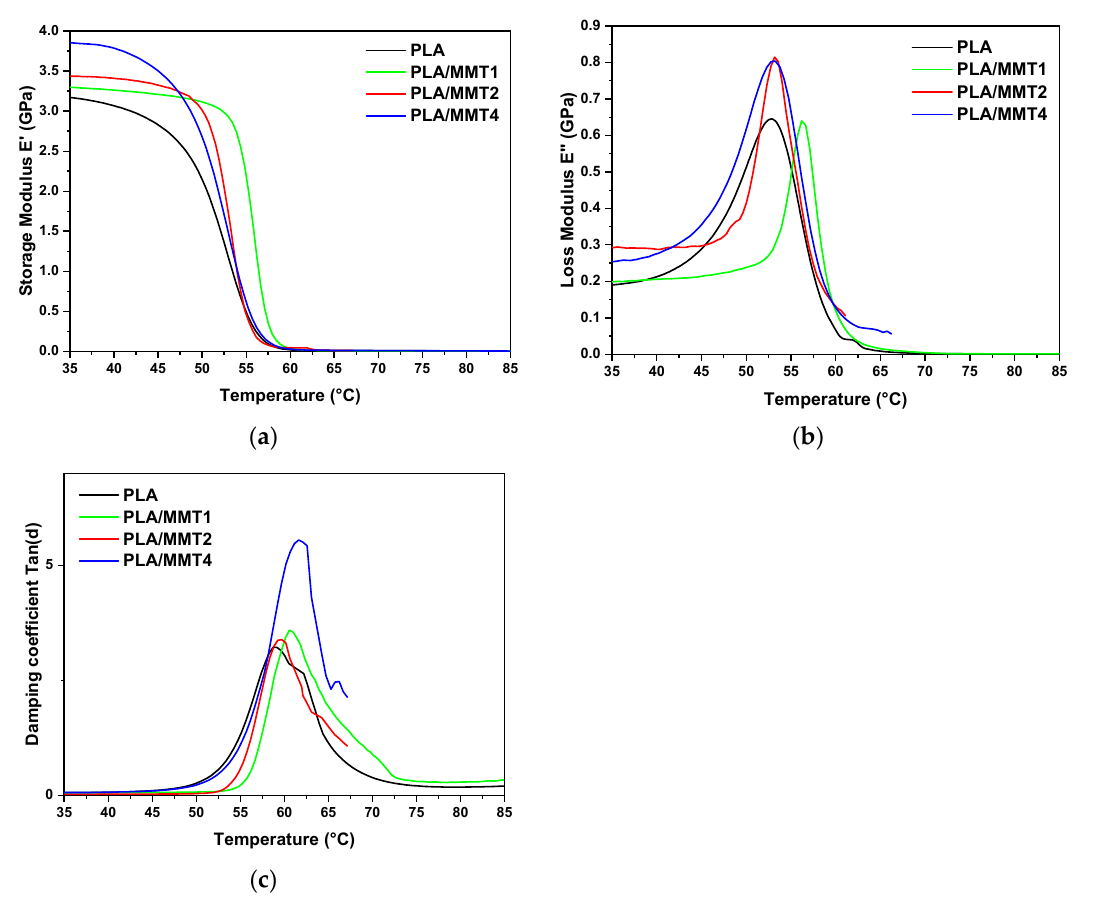
Figure 10. Effect of MMT content on the ( a ) E i Compression Modulus and ( b ) Ultimate Compression Stress of PLA/MMT 3D-printed specimens. ** p ≤ 0.01.